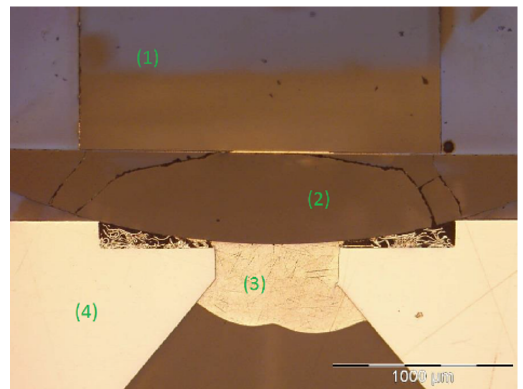
Figure 5. Cross section of an output mirror after soldering. (1) Output mirror pre-soldered to the (2) semi-spherical body made of fused silica and (3) soldered by a 760 µ m SAC305 alloy to the (4) KOVAR pad. All the components have been locally metallized with Ti/Pt/Au layer on the areas that have to be